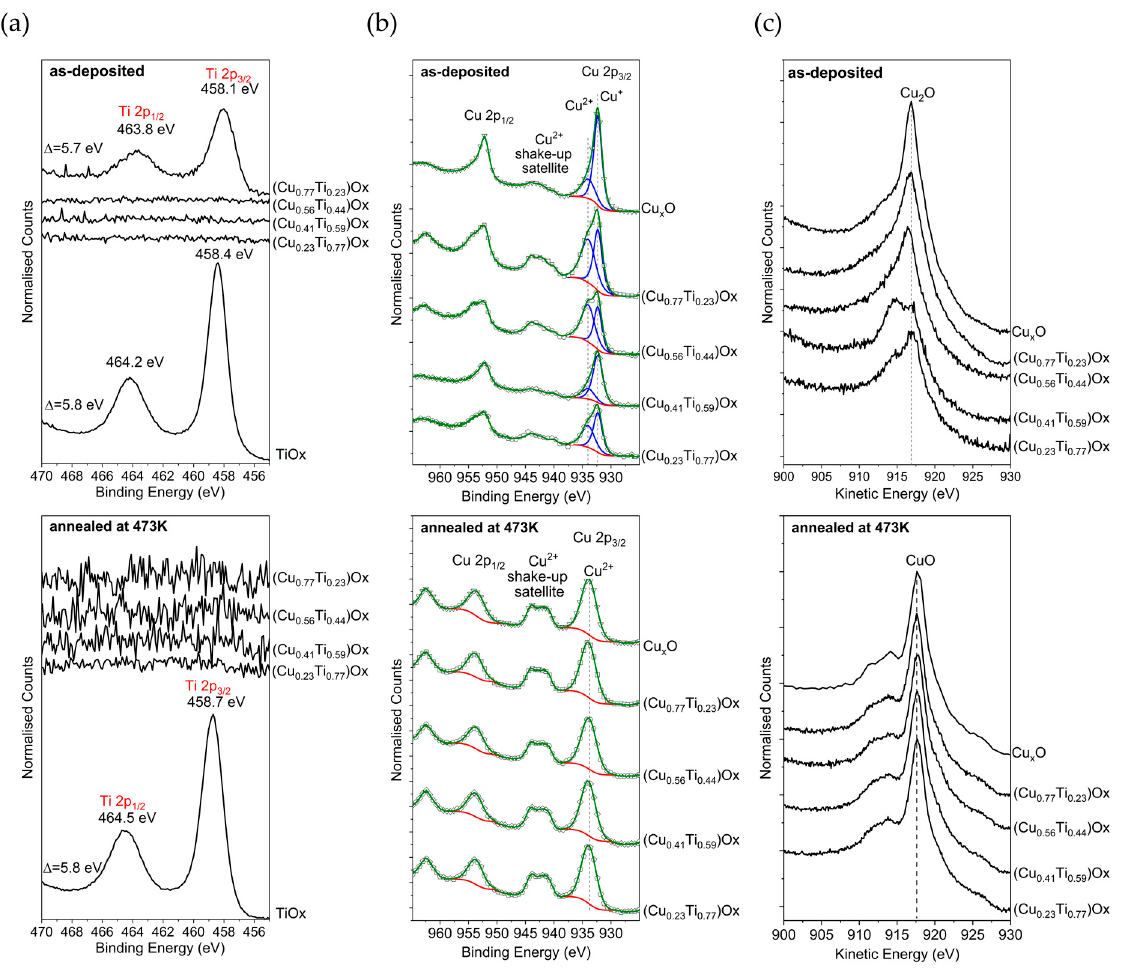
Figure 3. XPS spectra of ( a ) Ti2p; ( b ) Cu2p; and ( c ) Cu LMM of the as-deposited and annealed thin fi lms.